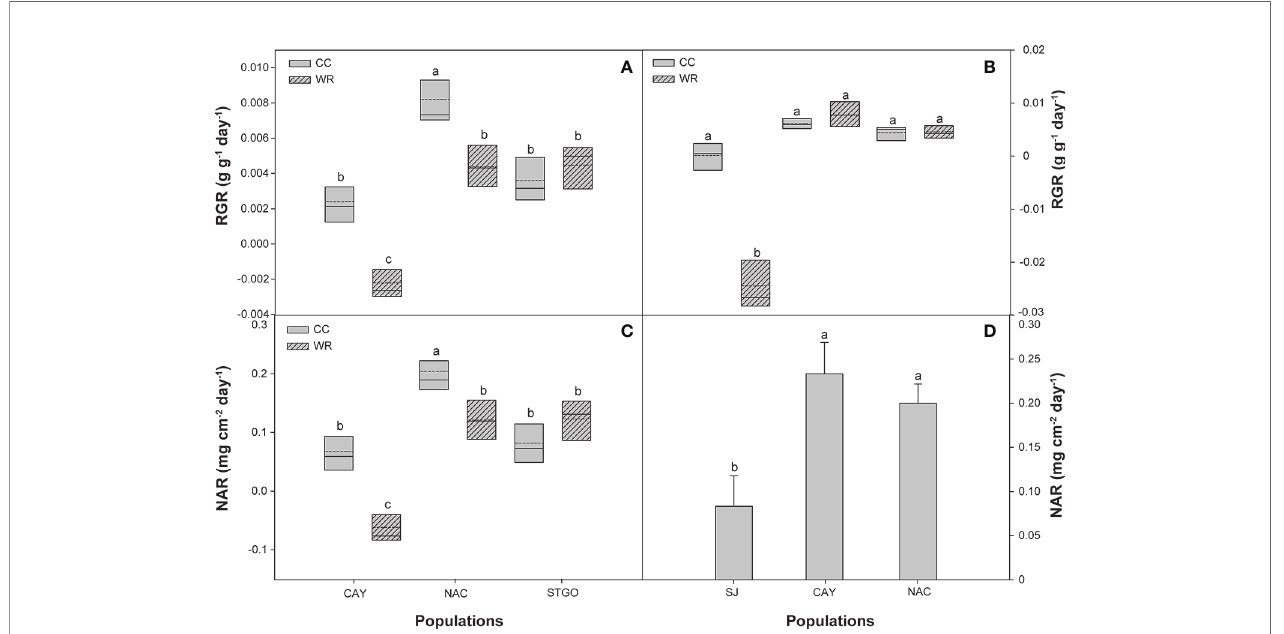
FIGURE 7 | Effect of population and irrigation treatment on relative growth rate (RGR, g g -1 day -1 ) and net assimilation rate (NAR, mg cm 2 day -1 ) of Cryptocarya alba (A , C) and Persea lingue (B, D) plants. In panels (A – C) , the bottom and top boundaries of the boxes represent the 25 th and 75 th percentiles, respectively. The solid line in the center of each box represents the mean value and the dashed line represents the median value. Different letters indicate signi fi cant differences among populations and irrigation treatments according to Tukey at p<0.05. In panel D, bars indicate means + SE. Different letters indicate signi fi cant differences according to Tukey at p < 0.05. CAY, Cayumanque; NAC, Nacimiento; STGO, Santiago; SJ, Santa Juana; WR, water restriction; CC, container capacity.